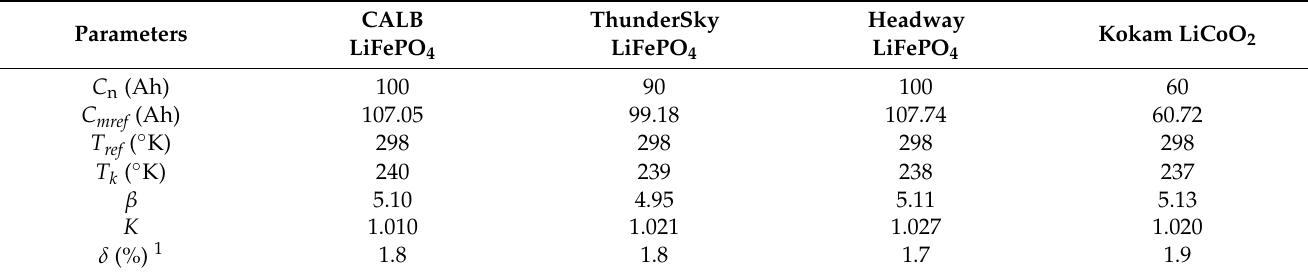
Table 2. Optimal values of parameters for Equation